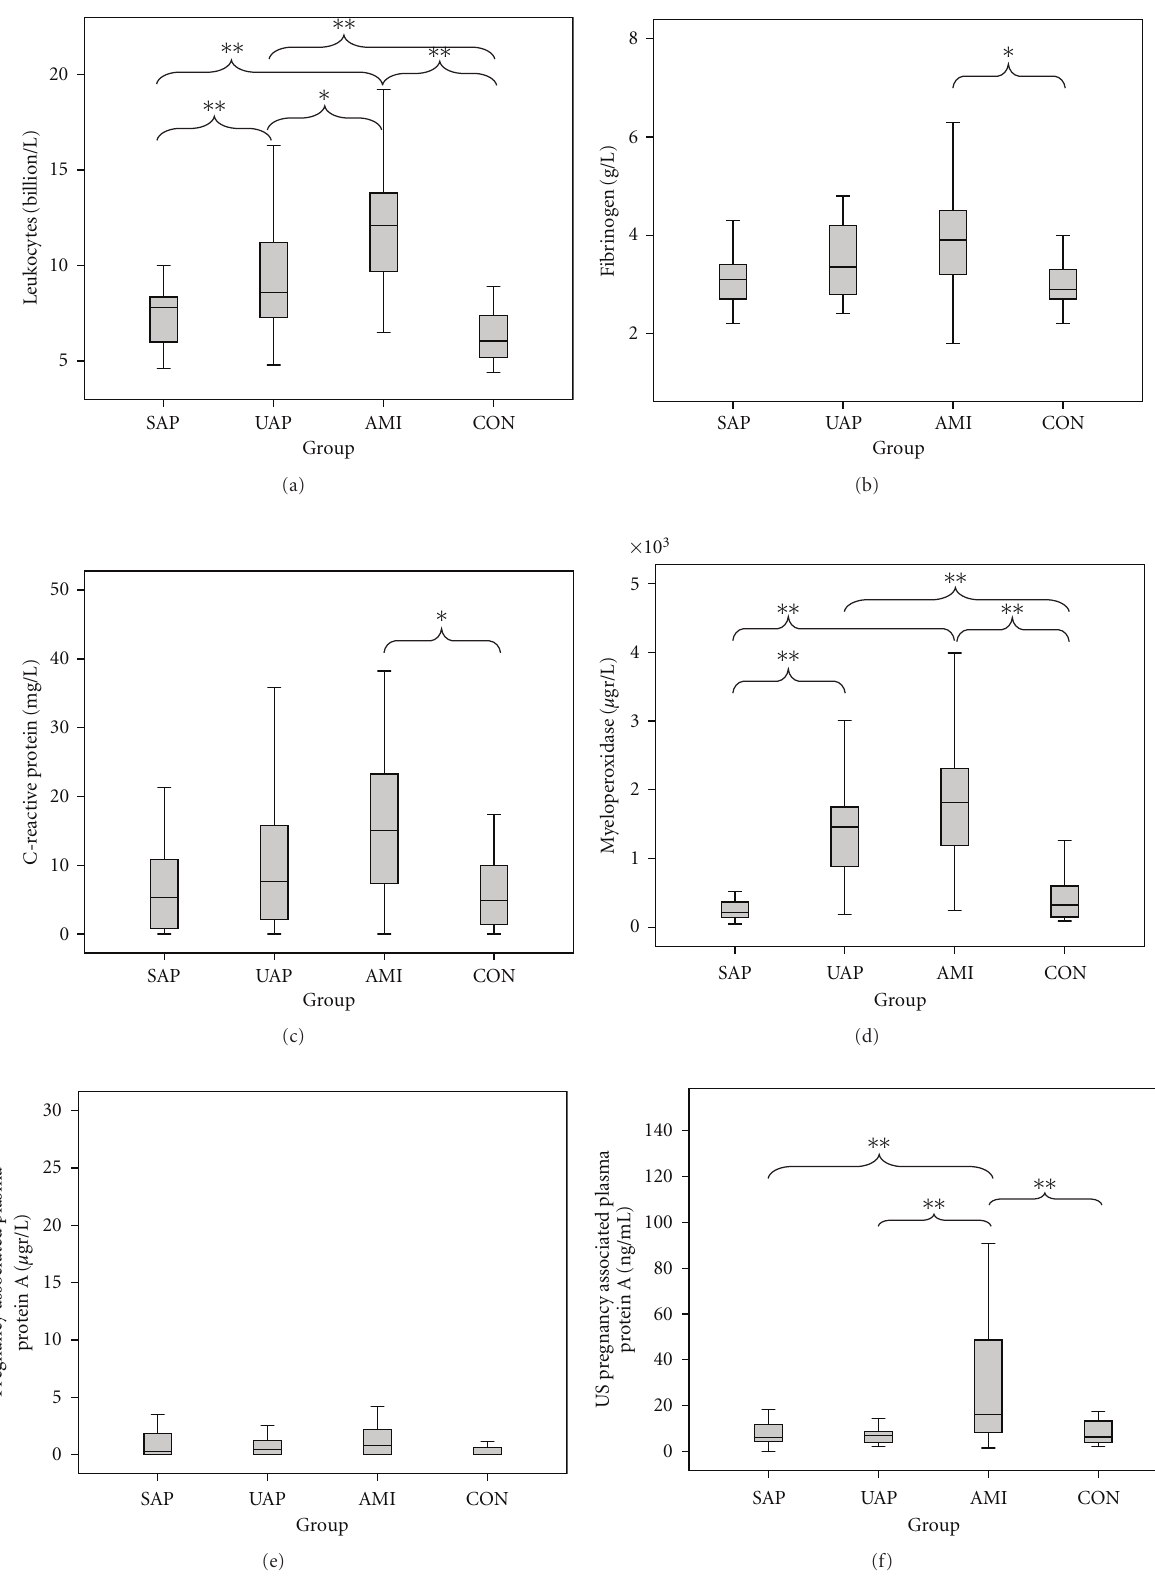
Figure 1: Boxplots of biomarkers levels at study inclusion of leukocyte counts (a), fibrinogen (b), CRP (c), myeloperoxidase (d), PAPP-A (e), and US PAPP-A (f). Statistical di ff erences are expressed as P < . 05 ( ∗ ) ot P ≤ . 001 ( ∗∗